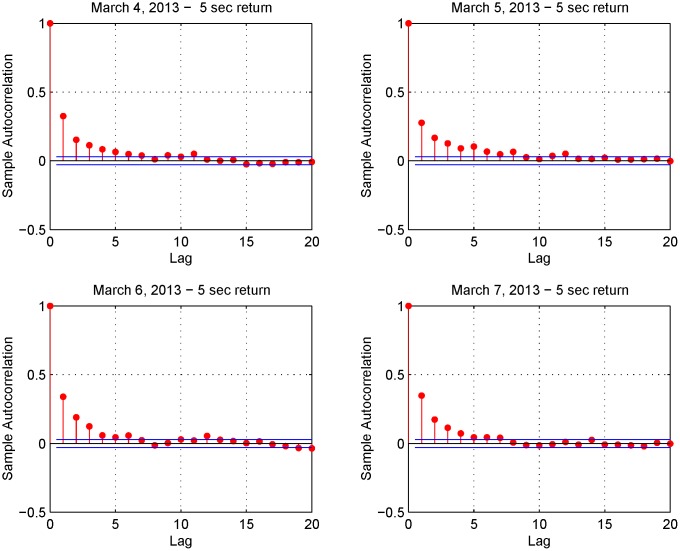
Autocorrelation functions.The four panels show the autocorrelation in 5-second returns (March 4-7, 2013).